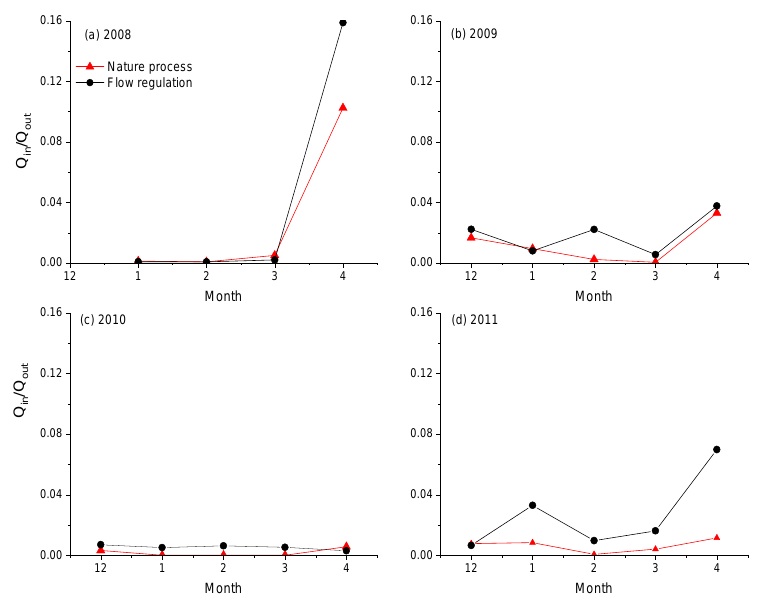
Figure 5. Variation in coefficient of water exchange in the river ‐ lake system with and without the TGR. Q in is the total flow through the three inlets (Songzi, Taiping, Ouchi); Q out is the outflow through the Chenglingji outlet; The natural processes are the results without the TGR, while the flow regulation is the results under the operation of the TGR.